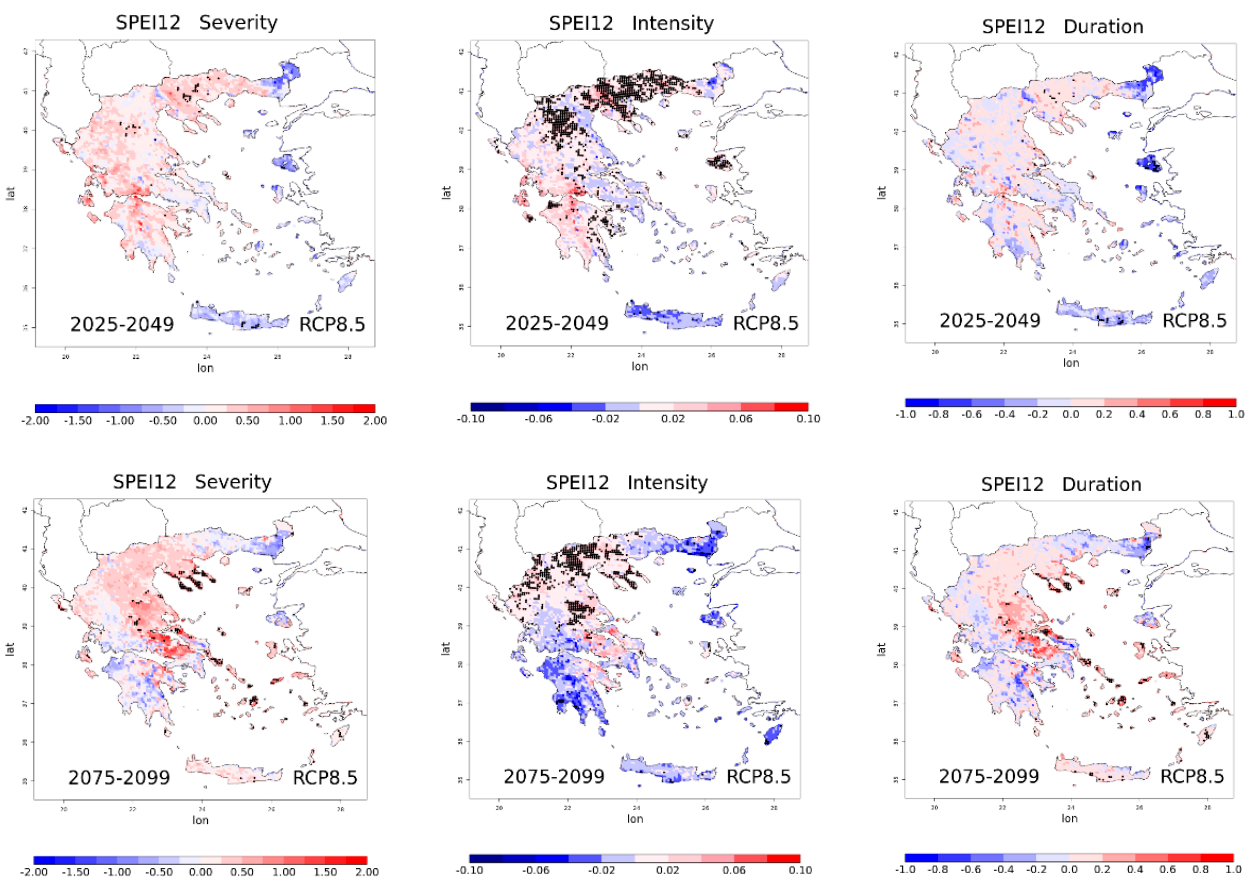
Figure 15. Trends (per year) of severity ( left ), intensity ( center ), and duration ( right ) for the 12-month SPEI under RCP4.5 and RCP8.5 for the period 2025–2049 and 2075–2099 over the area of Greece. The black dotted areas show significant changes in the drought characteristics at the 5% significance level.